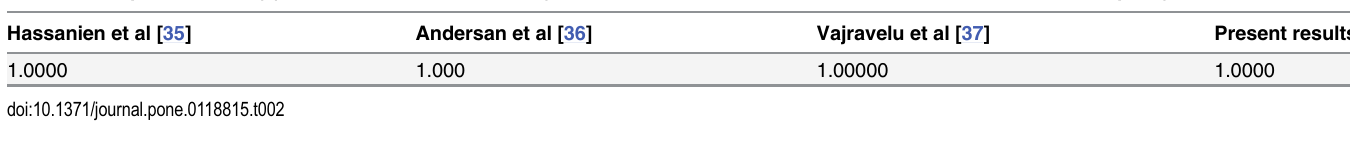
Table 3. Comparison of θ 0 (0) with Hassanien et al. [35] for various values of Pr and temperature exponent n when λ = 0, γ = 0, β = 0 and ε = 0 (i.e., for Newtonian fl uid without mixed convection over a fl at plate with constant thermal conductivity). n Pr =